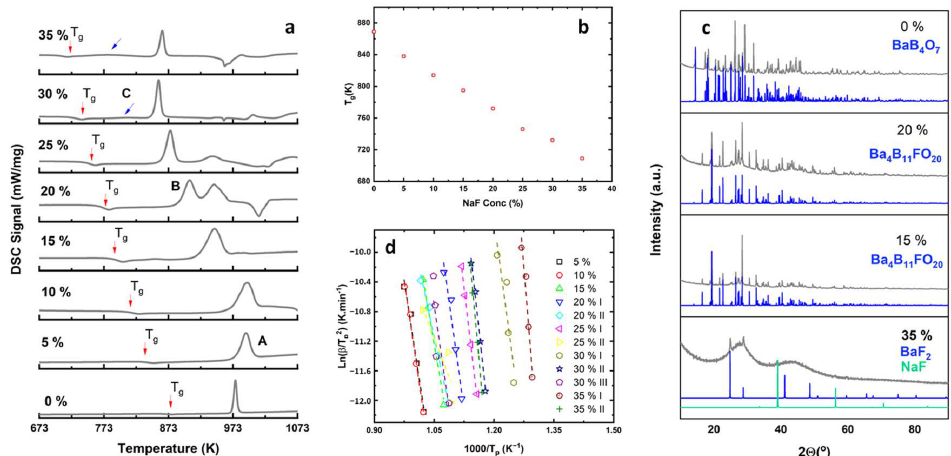
Figure 3. ( a ) DSC signal as a function of NaF concentration. Red arrows indicate the value of T g for visualization. Blue arrows indicate the wider peak identified as C. ( b ) Variation of T g as a function of NaF concentration. ( c ) XRD diagram for different samples heat-treated at different temperatures. Blue indicates the identified crystalline phase. ( d ) Kinetic analysis of crystallization for different samples.